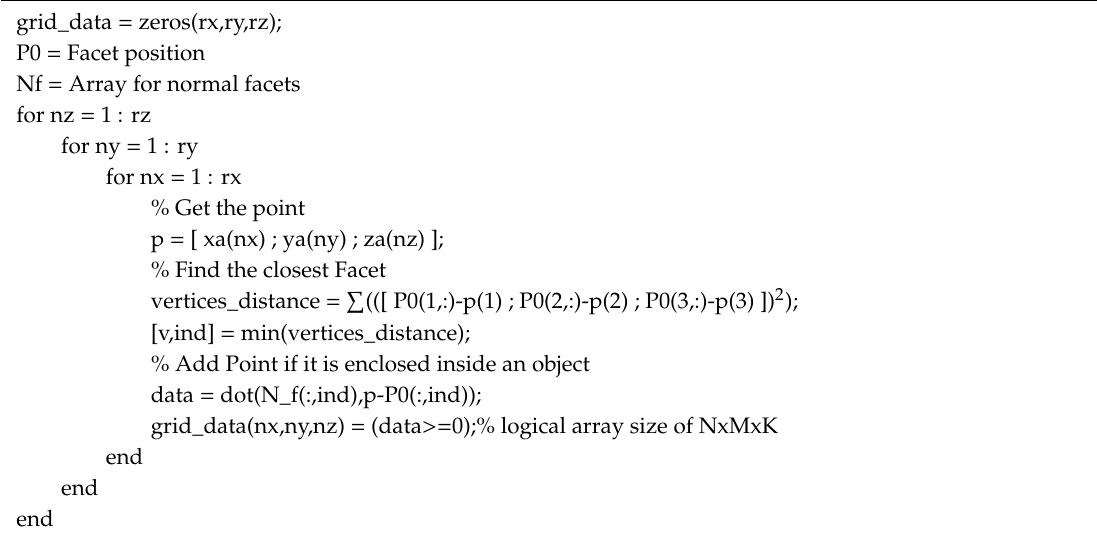
Algorithm 1 : Pseudocode for voxelization as a binary logic